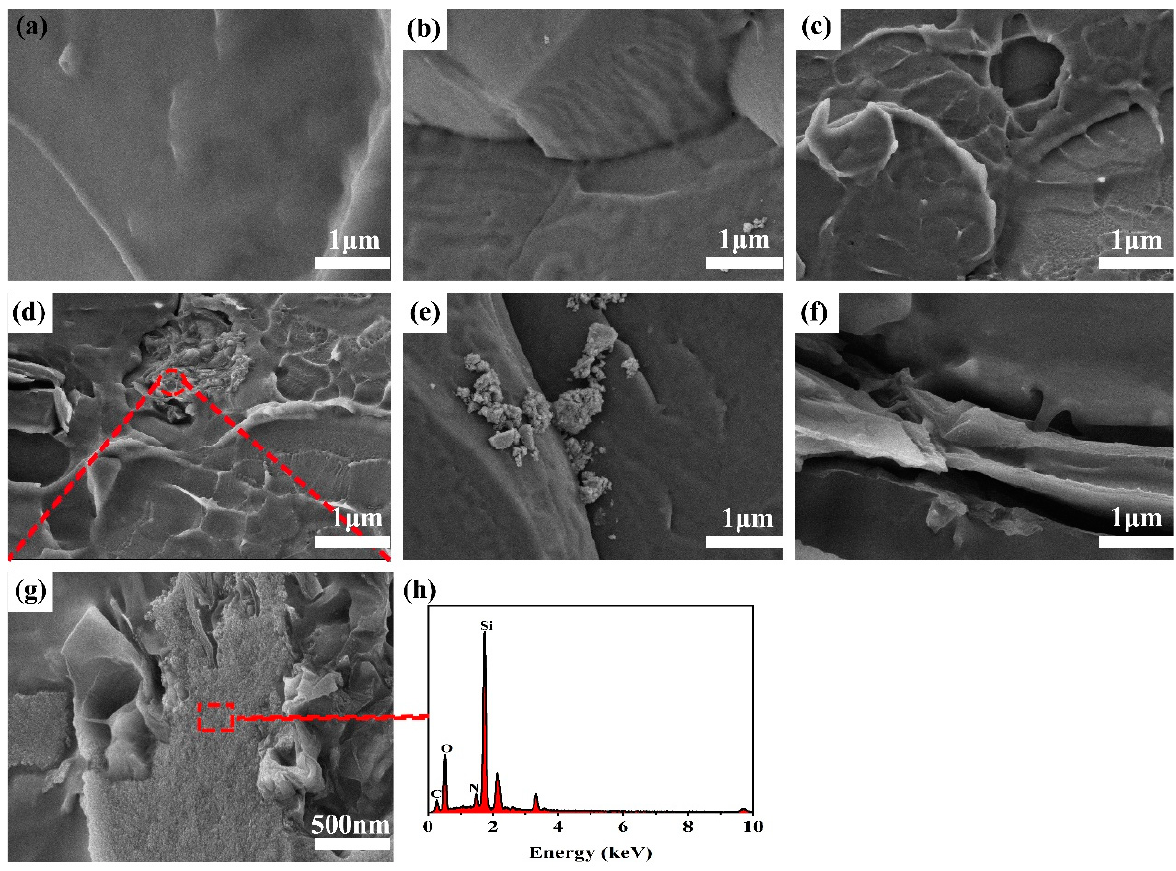
Figure 7. Cross-sectional SEM of TPU composites with different fillings ( a ) S0 ( b ) S1 ( c ) S2 ( d ) S3 ( e ) S4 ( f ) S5, ( g ) enlarged view of the red circle ( h ) EDS spectra of the red circle.